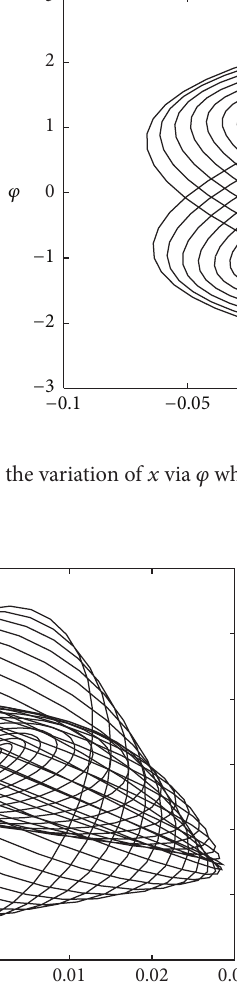
(c) of the same figure explicates the variation of 𝑥 versus 𝜑 at the same values of 𝜎 1 and 𝜎 2